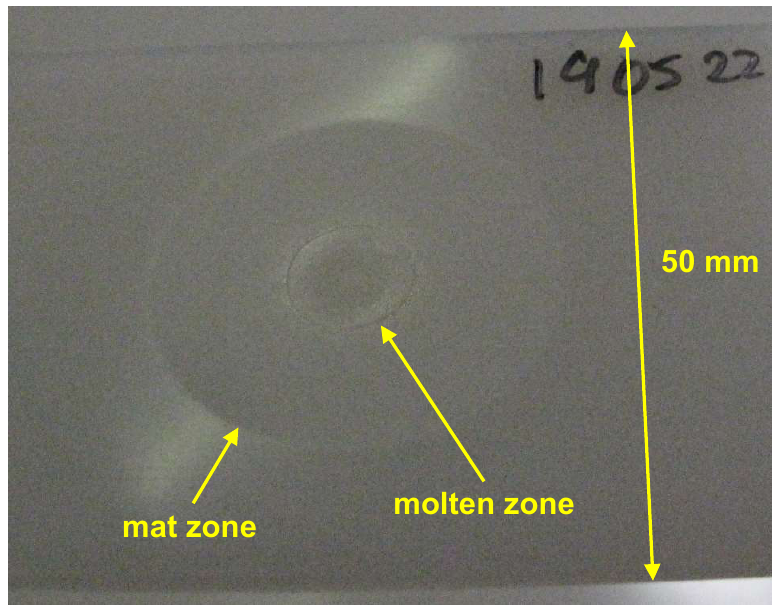
Figure 12. The picture of the HDPE substrate taken after treatment in configuration A operated at conditions from Table 1. The treatment time is 3 s.